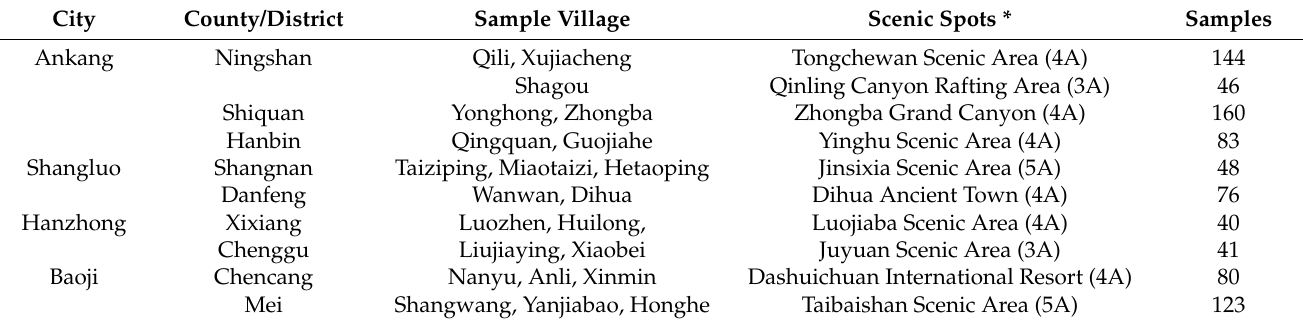
Table 1. The distribution of survey areas, sample villages, and scenic